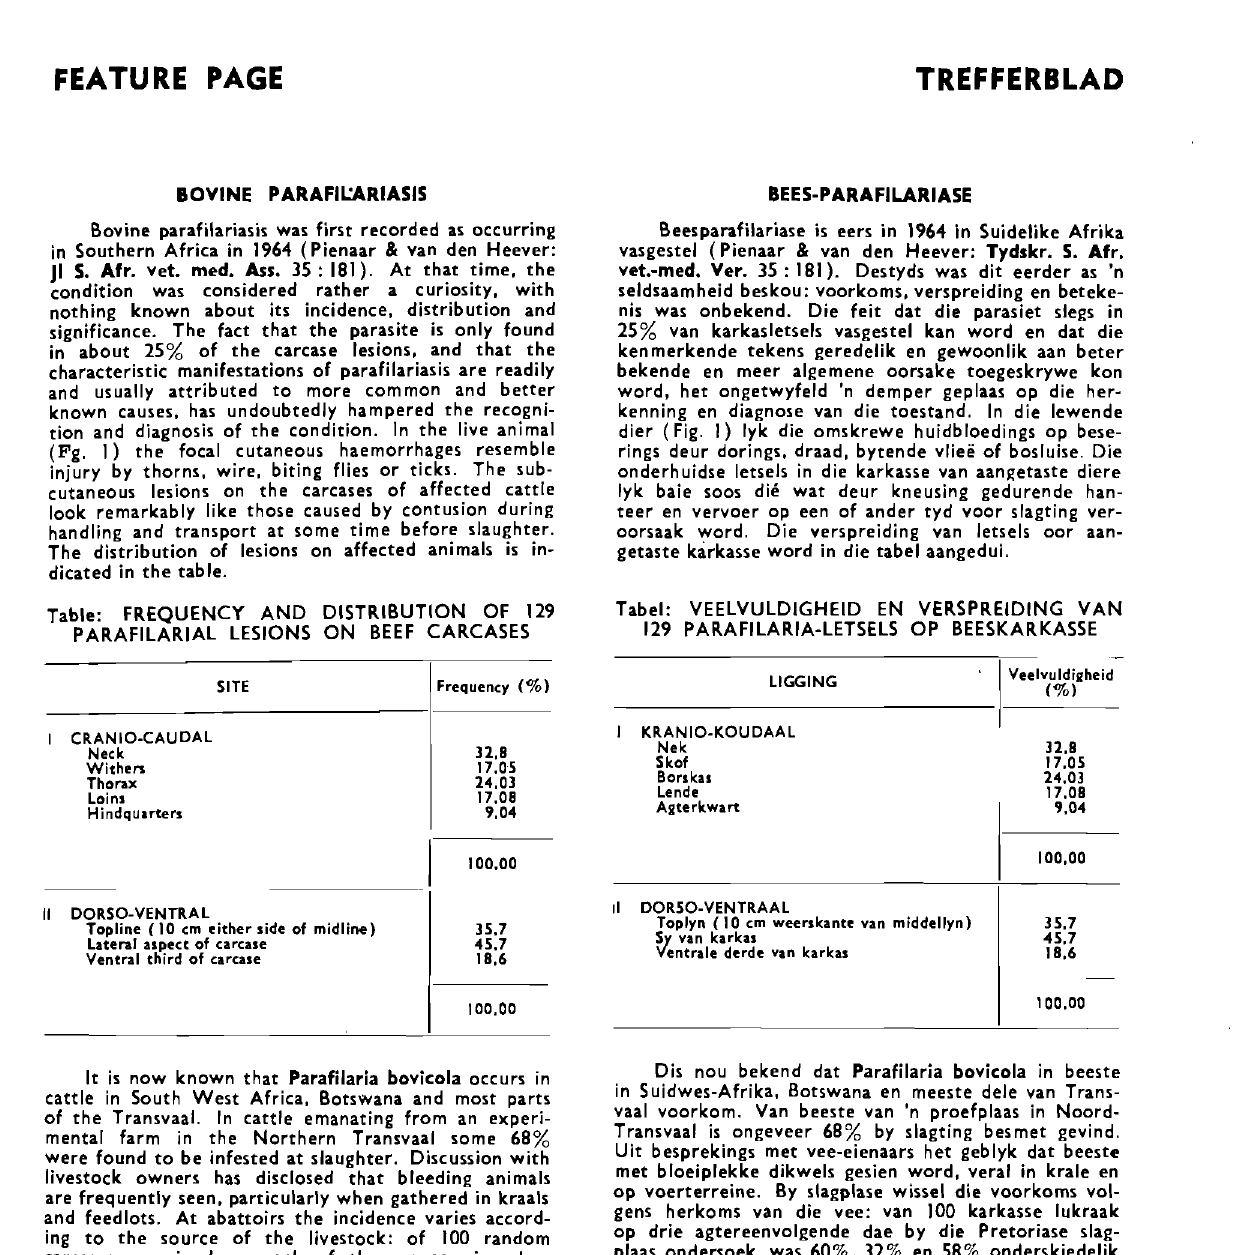
CRANIO-CAUDAL Neck Withers Thorax Loins Hindquarters